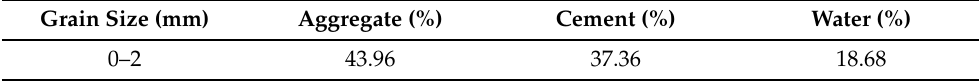
Table 1. Materials proportions in weight (kg) of the produced samples.